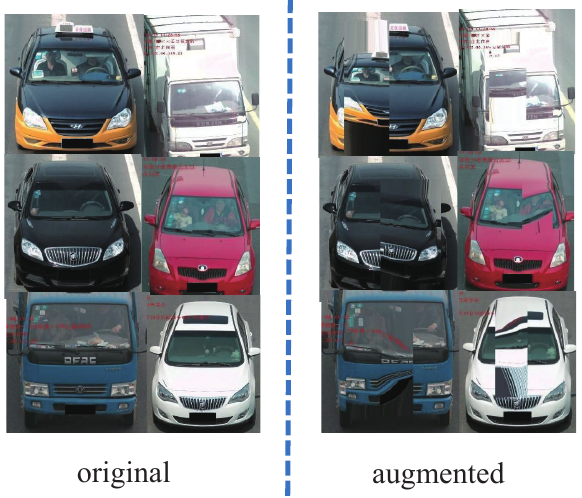
Figure 1. Image augmentation results from an original to an augmented